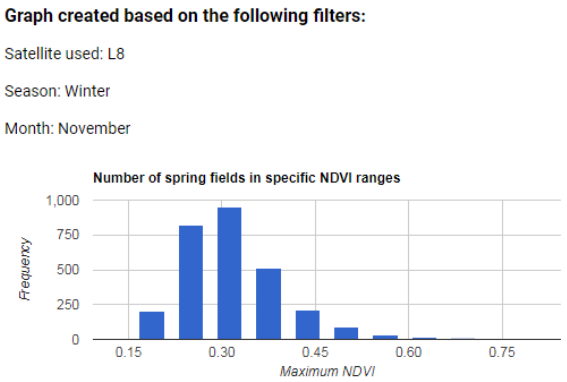
Figure 5. CCROP output histogram showing number of fields versus maximum NDVI for fields planted in